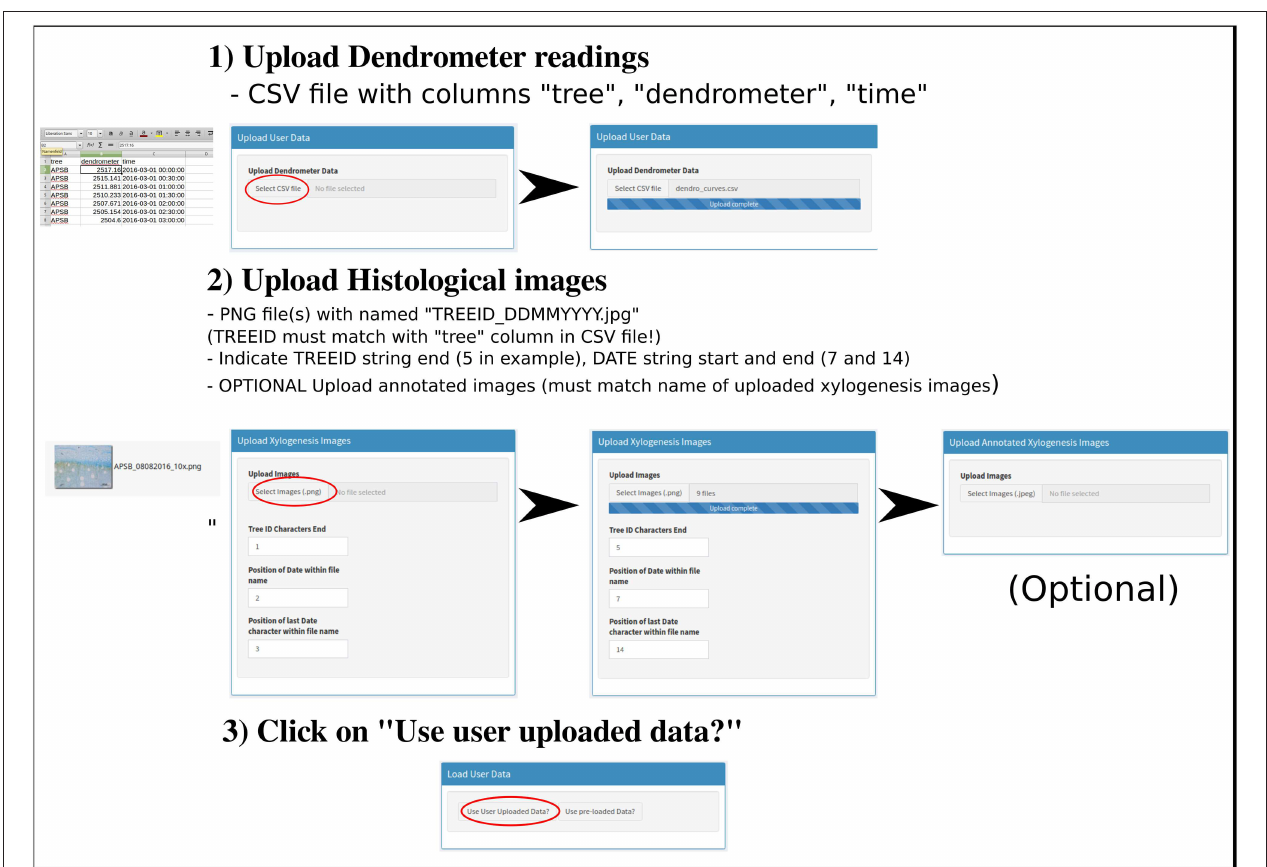
FIGURE 2 | Graphical instructions on how to upload user data. After completing the outlined steps, the “Dendro/Thin-section Viewer” page will load showing the dendrometer curve and available xylogenesis